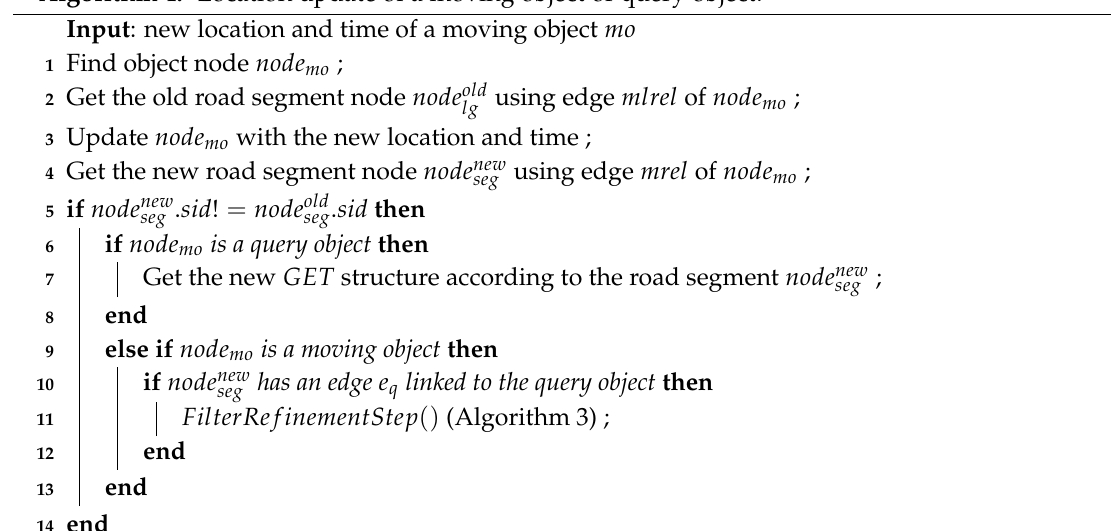
Algorithm 4: Location update of a moving object or query